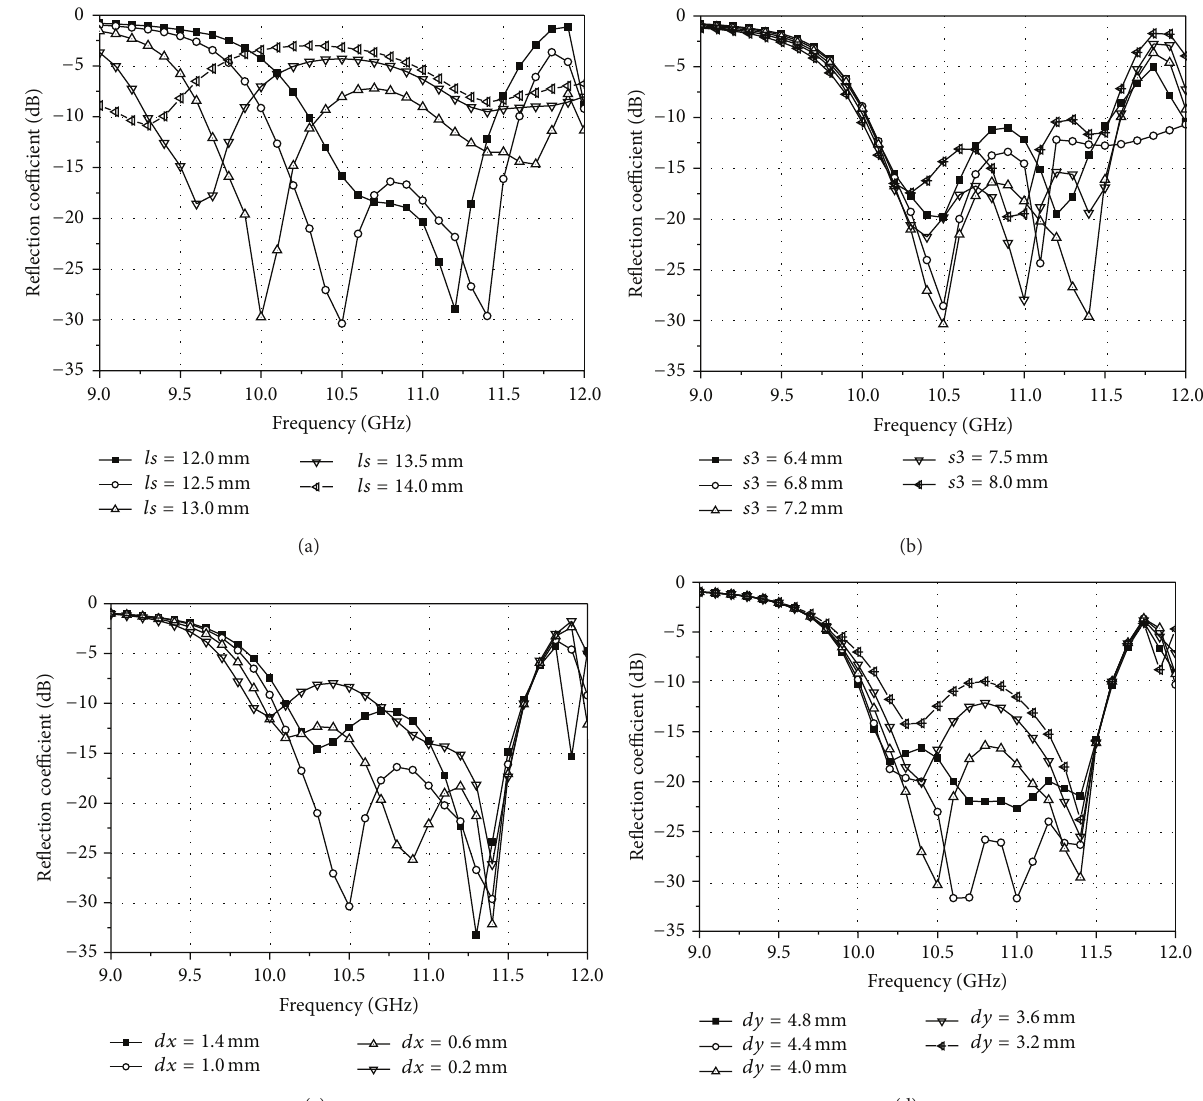
Figure 2: Impedance matching characteristics according to the variation of (a) 𝑙𝑠 , (b) 𝑠3 , (c) 𝑑𝑥 , and (d) 𝑑𝑦 .